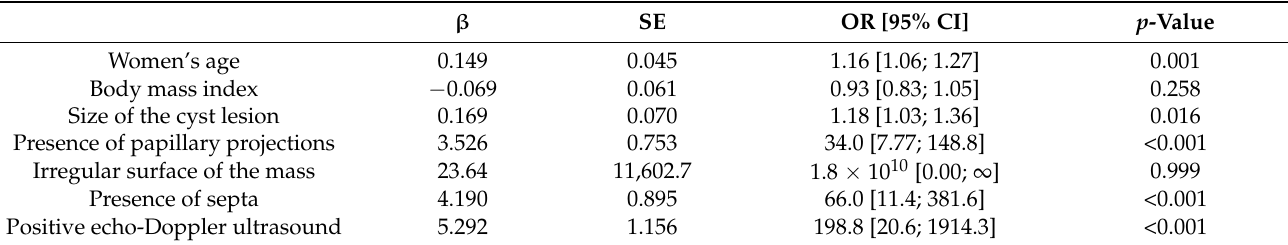
Table 3. Multivariate logistic regression models associated with the malignancy endometriosis